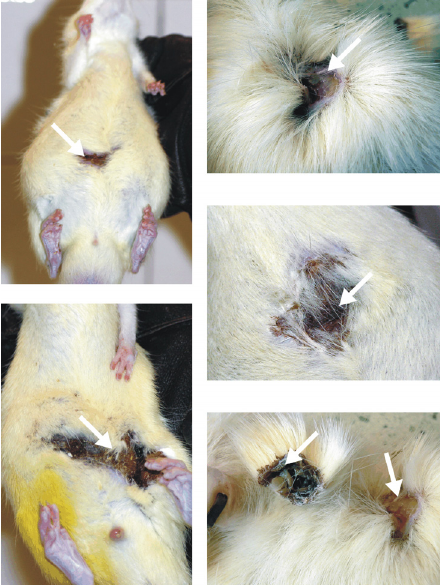
Figure 9. Skin irritation and inflammation in animals given PAMAM G4 dendrimers by intraperitoneal injection. The arrows indicate hair loss, reddening of the skin and abscesses filled with sanguine pus. For a description of the experimental design, please see the